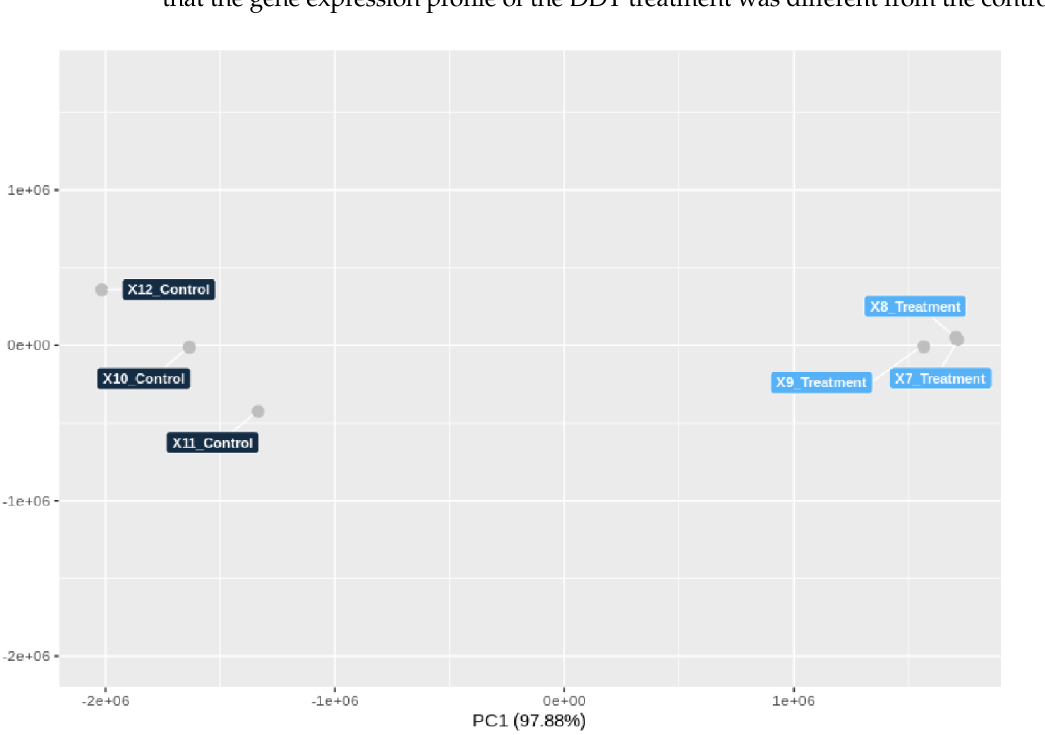
Figure 6. A plot reporting results from transcriptomic analysis for T. hamatum FBL 587 following exposure to DDT (10 mg/L for 48 h), in which blue dots represent the genes (4710) that were significantly expressed (FDR ≤ 0.05) by exposure to DDT, with log2FC ≥ 1 for upregulated genes (1706) and log2FC ≤ −1 for downregulated genes (1770), where x-axis is the gene number and y-axis is log2FC value. Abbreviations: FDR, False Discovery Rate (Benjamini-Hochberg correction); log2FC, fold change relative to control.